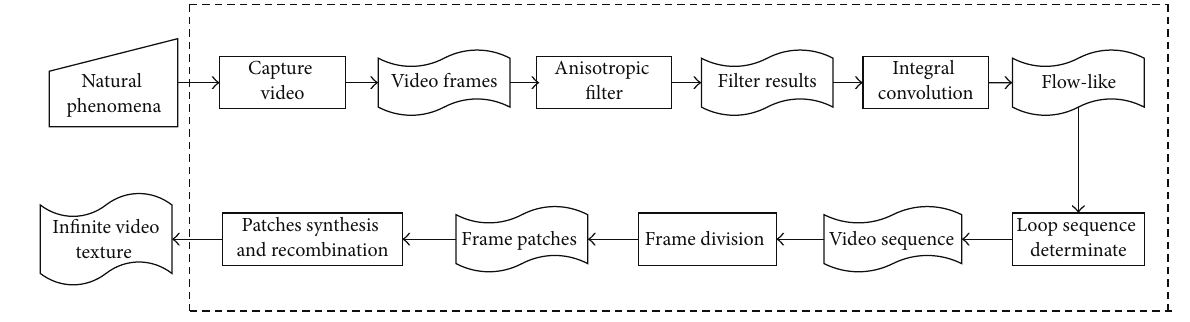
Figure 1: NP-video phenomena of our